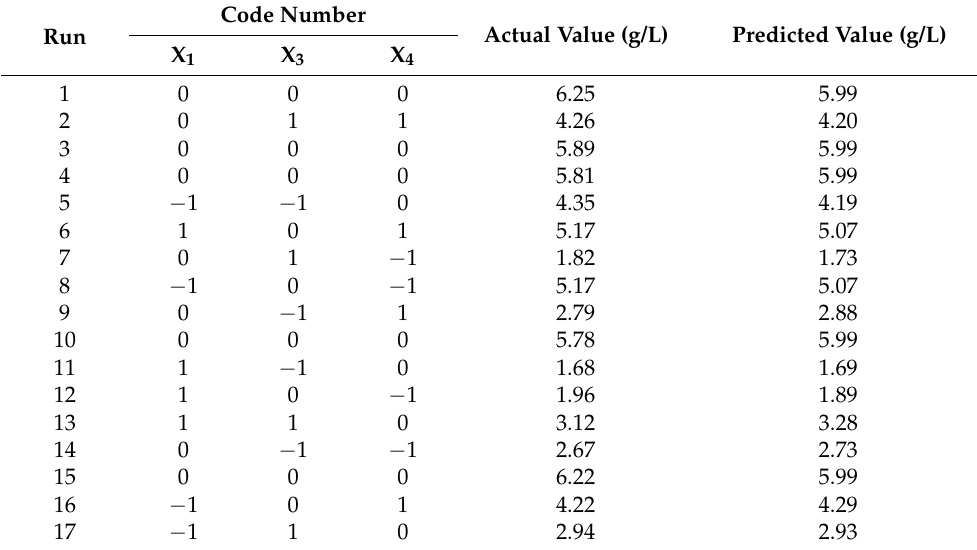
Table 6. The design and results of